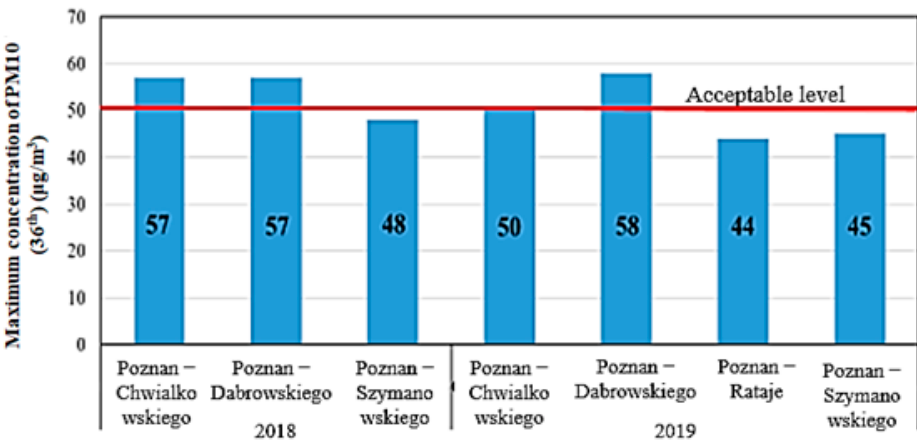
Figure 4. Maximum concentration of PM10 (36th) in Poznan [27,28].